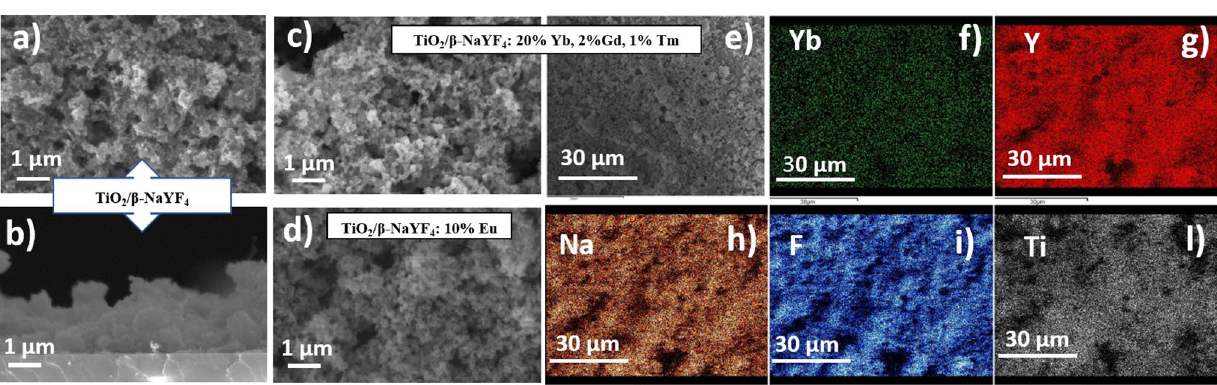
Figure 2. FE-SEM images of: TiO 2 /β-NaYF 4 deposited at 400 °C on Si (100), ( a ) plan view and ( b ) cross section;